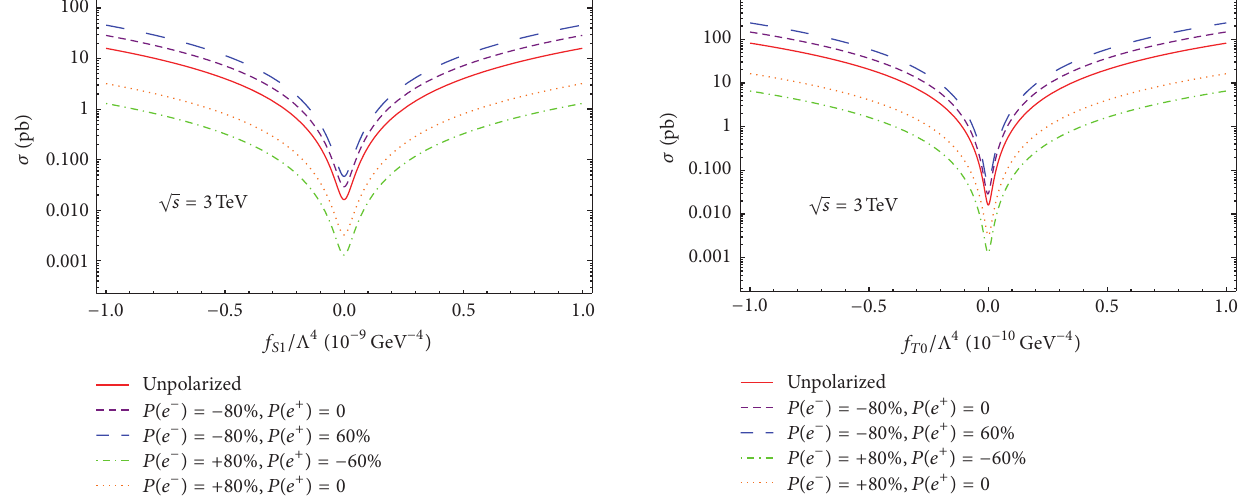
Figure 5: The total cross section for 𝑒 + 𝑒 − → ] 𝑒 𝑊 − 𝑊 + ] 𝑒 processes as a function of 𝑓 𝑆1 /Λ 4 at the √𝑠 = 3 TeV for different polarization of the positron and electron beams.